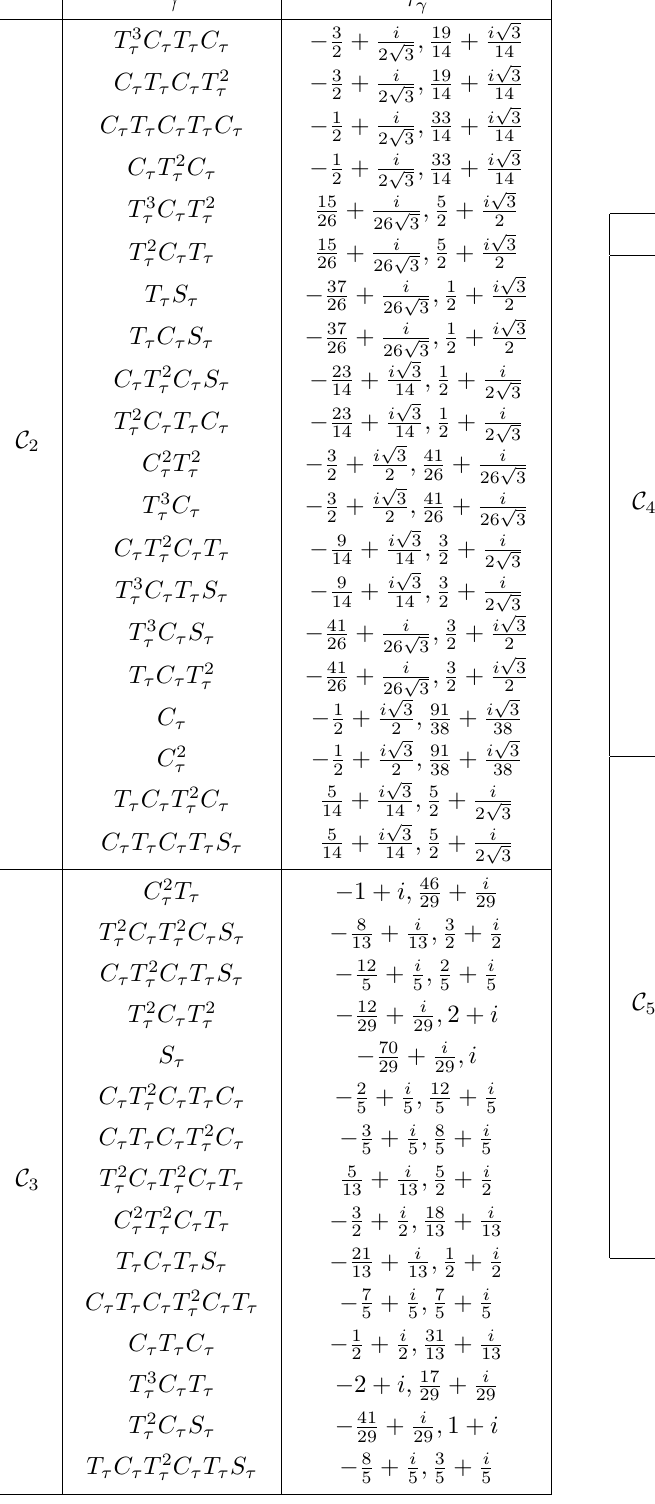
Table 4 . The non-identity elements of Γ 5 and respective